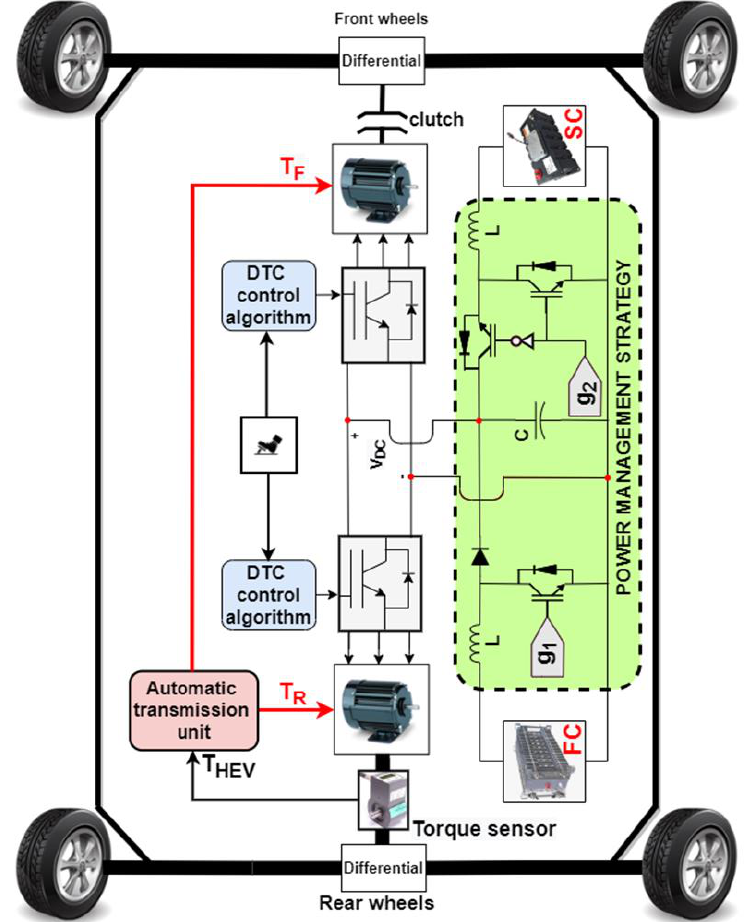
Figure 9. Overview of the FC-SC HEV.